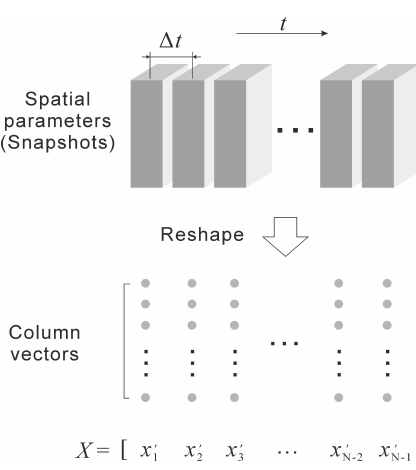
Figure 3. Pre-processing of data before applying